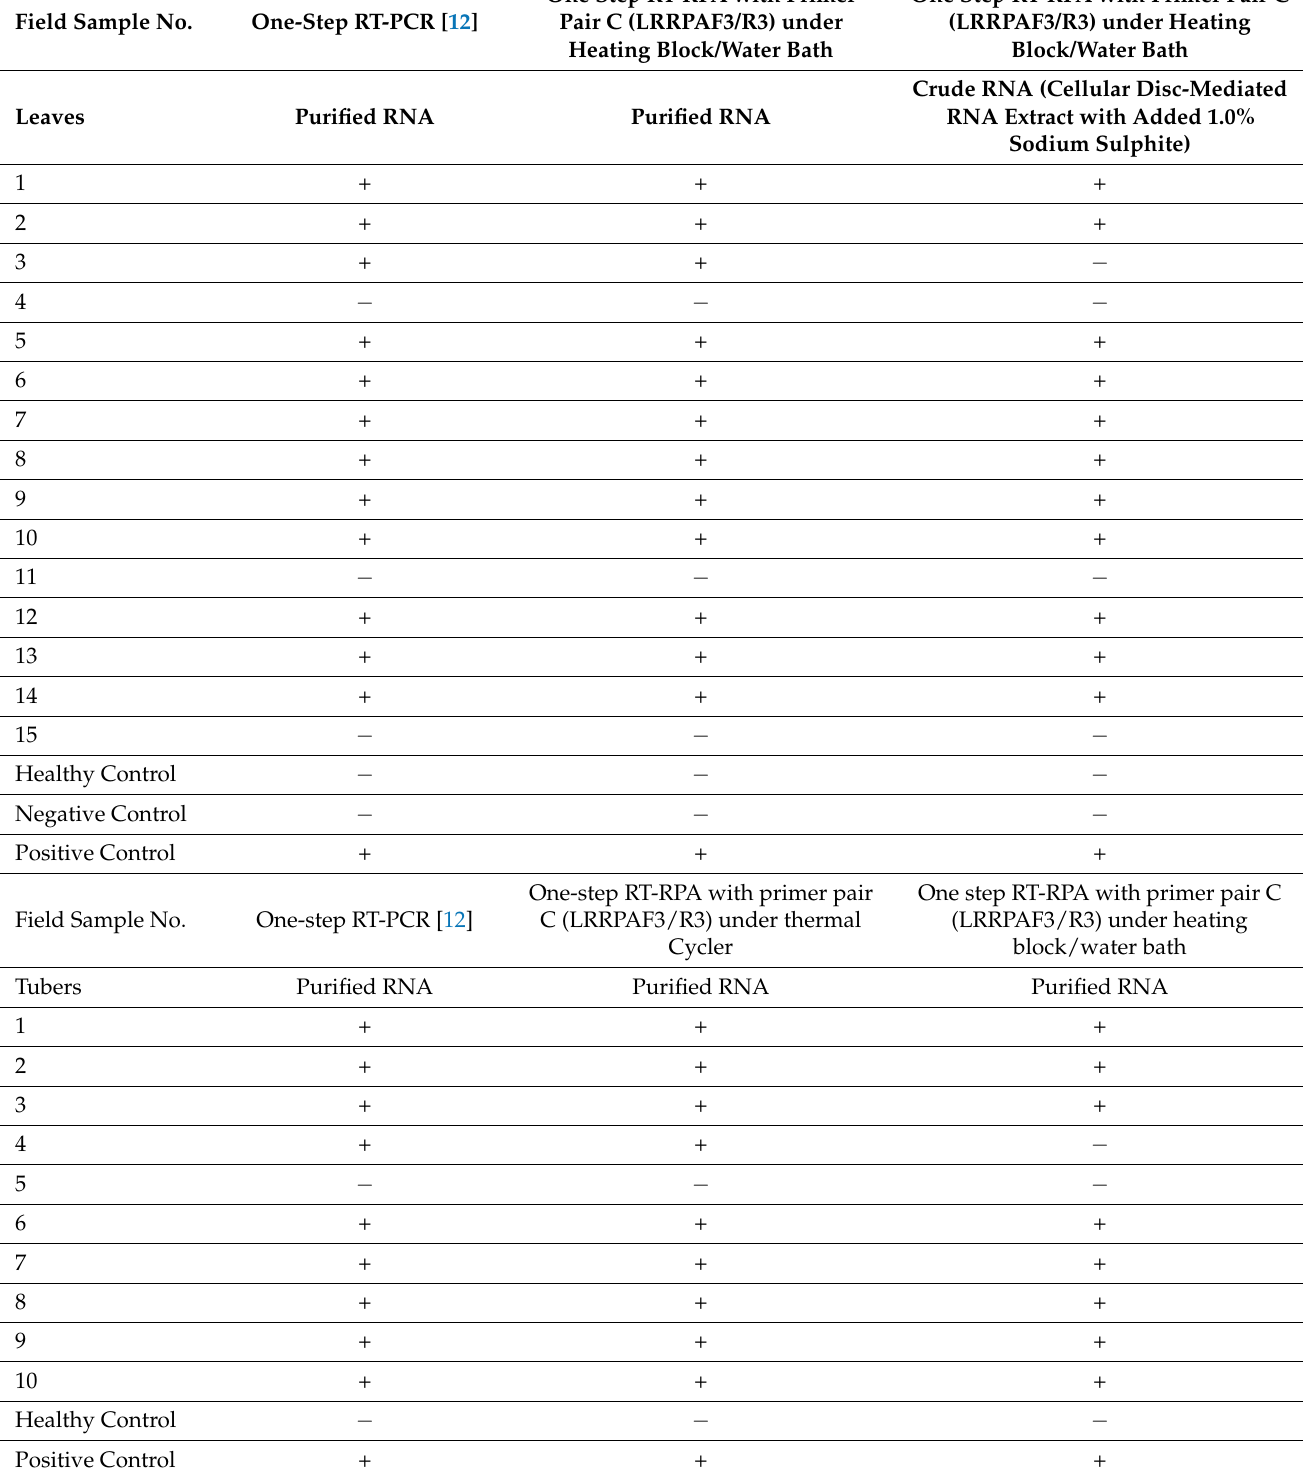
Table 2. Comparison and validation of potato leafroll virus (PLRV) detection methods, viz.,